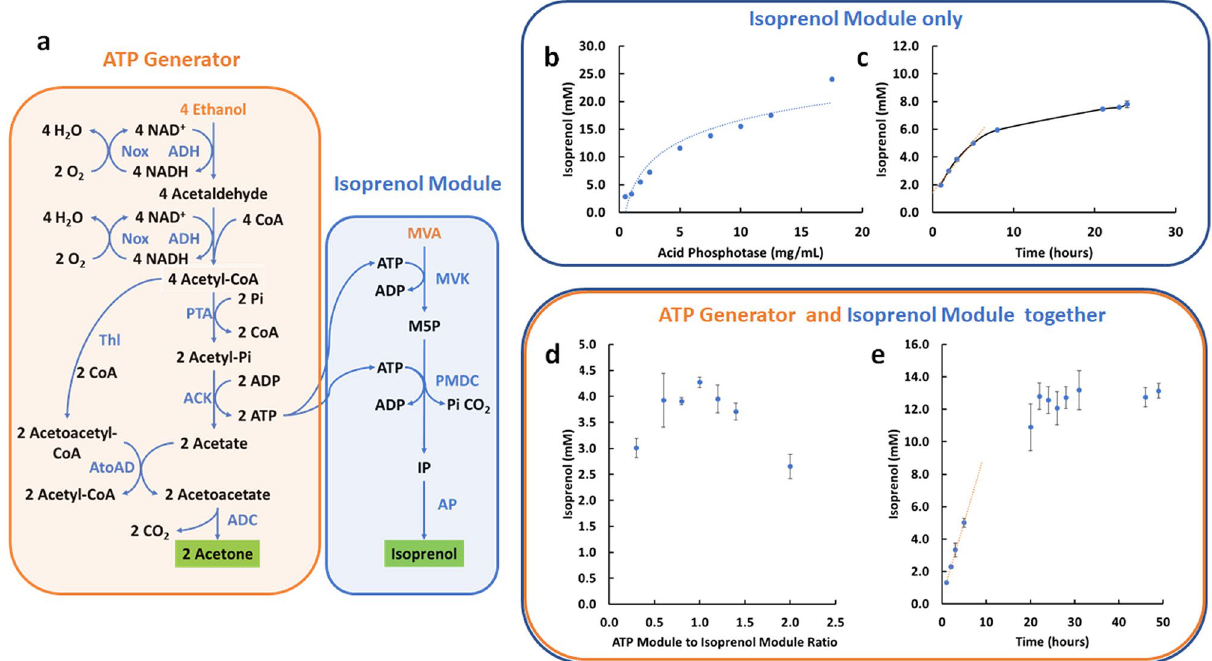
Figure 4. Coupling the ATP generator module to power isoprenol biosynthesis from mevalonate. ( a ) Schematic of the pathway employed. The ATP Generator Module supplies ATP to the two kinases required for the Isoprenol Module. ( b ) The AP amount limits the Isoprenol Module rate. The graph shows the amount of isoprenol produced by the isolated Isoprenol Module overnight as a function of the amount of AP added. To test the Isoprenol Module in isolation, ATP was supplied directly to eliminate the need for the ATP Generator Module. ( c ) Isoprenol production over time by the isolated Isoprenol Module. The AP concentration was set at 7 g/L. ATP was supplied to eliminate the need for the ATP Generator Module. ( d ) Optimizing the ratio of optimized ATP Generator Module enzyme concentrations to Isoprenol Module enzyme concentrations. The amount of isoprenol produced by the varying ratios after 5 h is shown as a measure of initial rate. The best ratio was found to be 1:1. ( e ) Isoprenol production over time using the full system shown in panel a and a 1:1 ratio of ATP Generator Module to Isoprenol Module enzymes. All assays experiments were performed in biological triplicates and the error bars reflect the standard phosphate, with the consumption of a second ATP. PMDC normally decarboxylates mevalonate pyrophosphate 32 but has been shown to also catalyze decarboxylation of the monophosphate (Supplemental Fig. 3) 31 . Finally, the isoprenol phosphate is hydrolyzed to isoprenol via an acid phosphatase (AP). In the designed system, the two ATPs required for the Isoprenol Module are supplied by the ATP Generator Module described above. We first worked to optimize the Isoprenol Module (MVA to isoprenol conversion) by supplying ATP directly rather than from the ATP Generator Module. From initial guesses at enzyme levels, we varied the enzyme con- centration by doubling or halving each enzyme individually and measured the amount produced after 16 h (See Supplemental Fig. 4 for details). The only enzyme concentration that significantly affected the titer was the Acid Phosphatase (AP). The other enzymes show minimal effects on titer when either doubled or halved. Hence, we worked to optimize the AP concentration as the AP dominates the total enzyme loading. As shown in Fig. 4b,